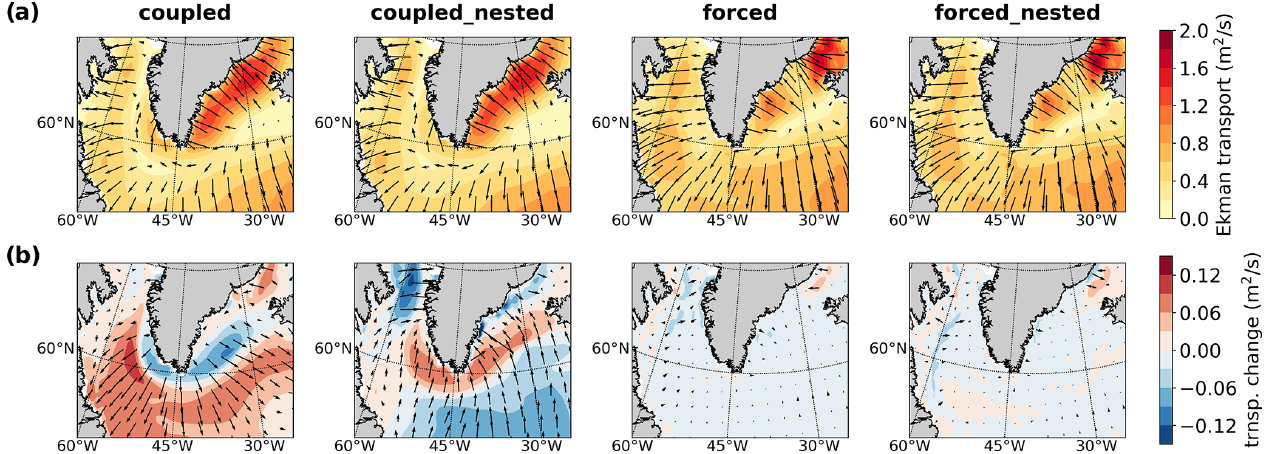
Figure 16. (a) Long-term annual-mean Ekman transport magnitude (colored contours) and direction (arrows, length relates to magnitude). (b) Response in Ekman transport to freshwater